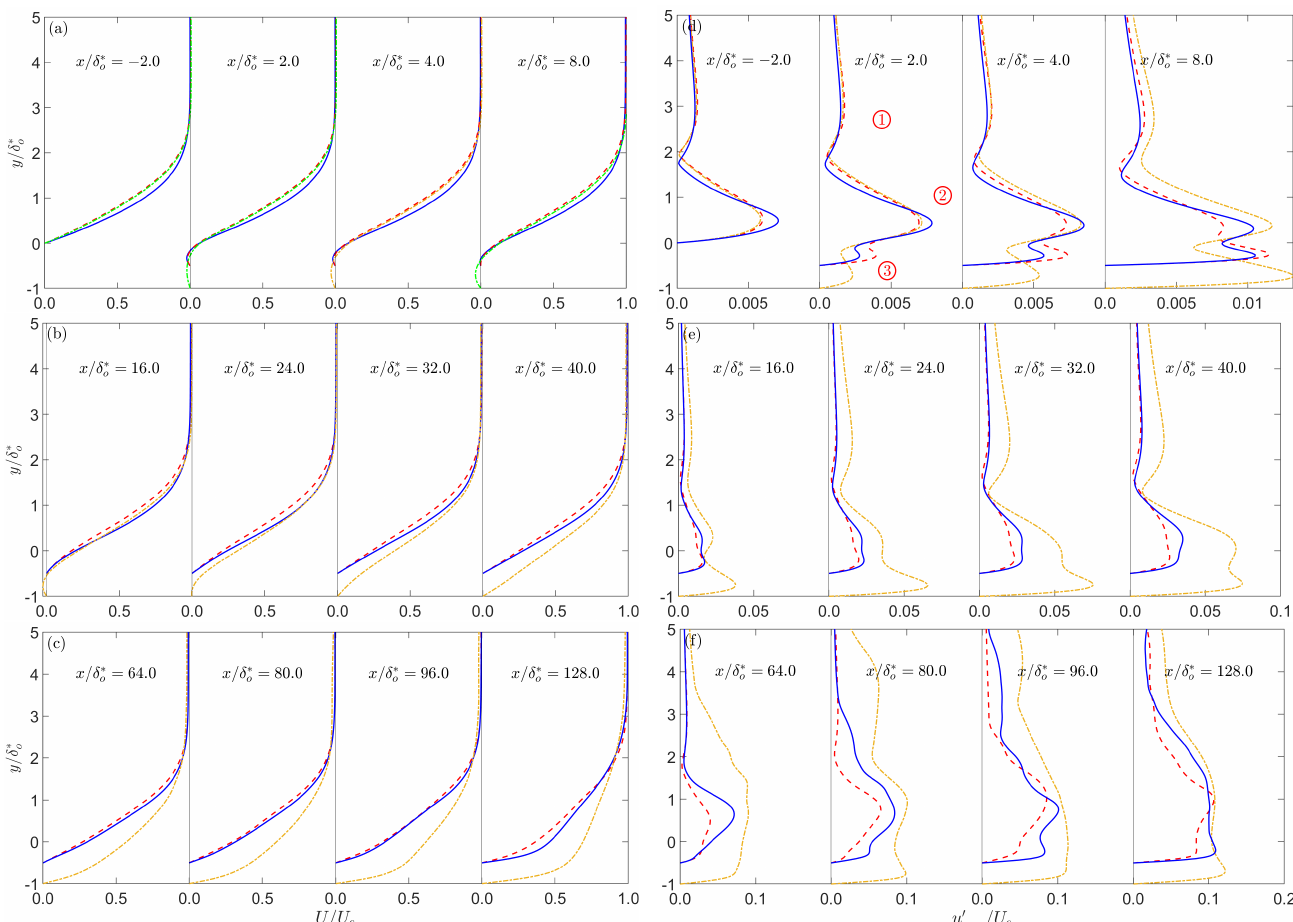
Figure 8. Profiles of ( a – c ) mean velocity and ( d – f ) u (cid:48) rms at selected locations. Small step; small step, variable U e ; , large